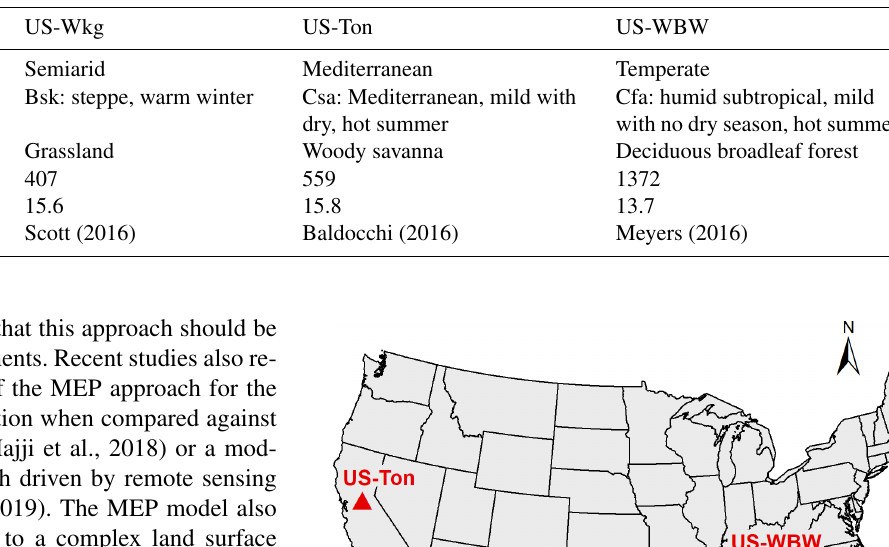
Table 1. Description of study sites.